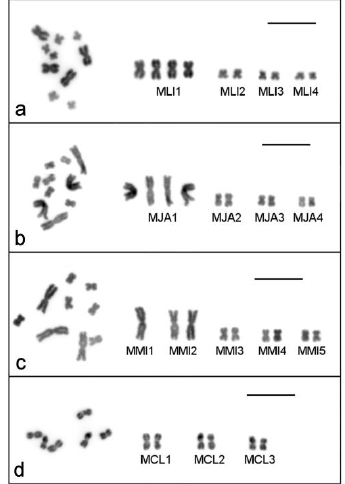
Figure 1. Metaphase plates (left) and karyotypes (right) of the four studied Macrostomum species: ( a ) 2 n = 10 karyotype of inbred DV1/10 line of M. lignano ; ( b ) 2 n = 10 karyotype of M. janickei ; ( c ) 2 n = 9 karyotype of M. mirumnovem ; ( d ) 2 n = 6 karyotype of M. cliftonensis . 4′,6 -diamidino-2-phenylindole (DAPI)-staining (inverted image). Scale bar 10 µm.